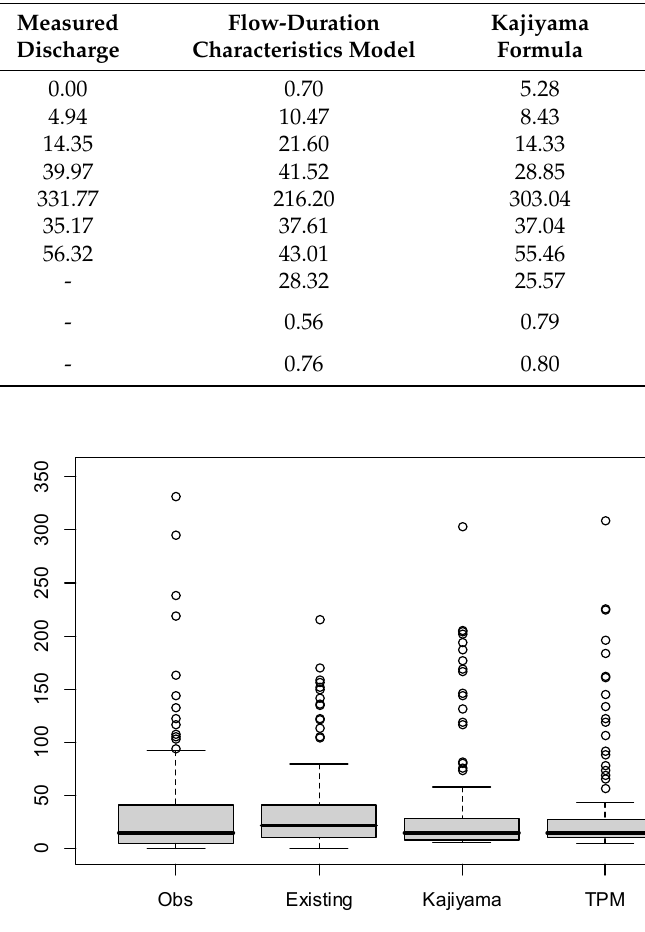
difference between the simulated and measured discharge